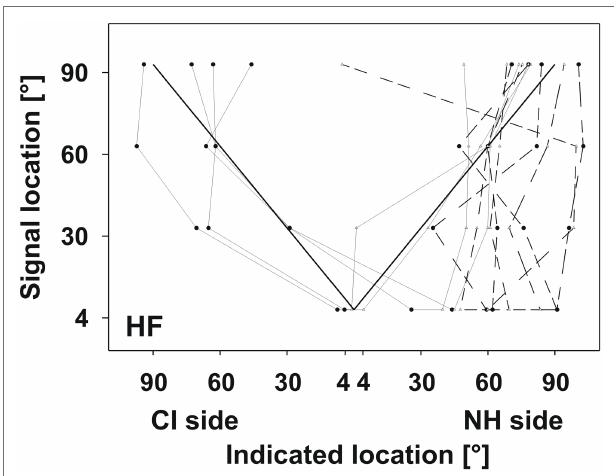
FIGURE 5 | Monaural vs. binaural test for HF signals. Layout of the plot as in Figure 3 . Solid lines indicate performance with the CI (identical to Figure 3 ). Dashed lines indicate performance without the CI, which was comparable to the poor performers.